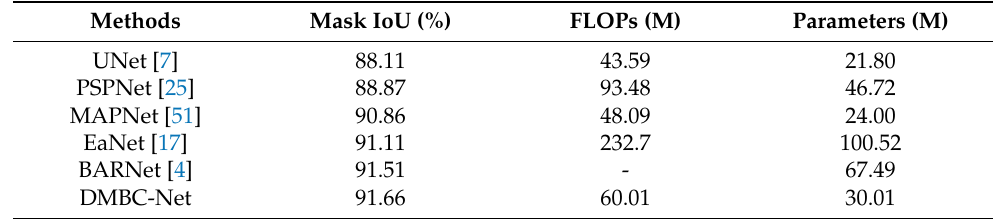
Table 6. Accuracy and model-complexity comparison of different methods using the WHU data set.